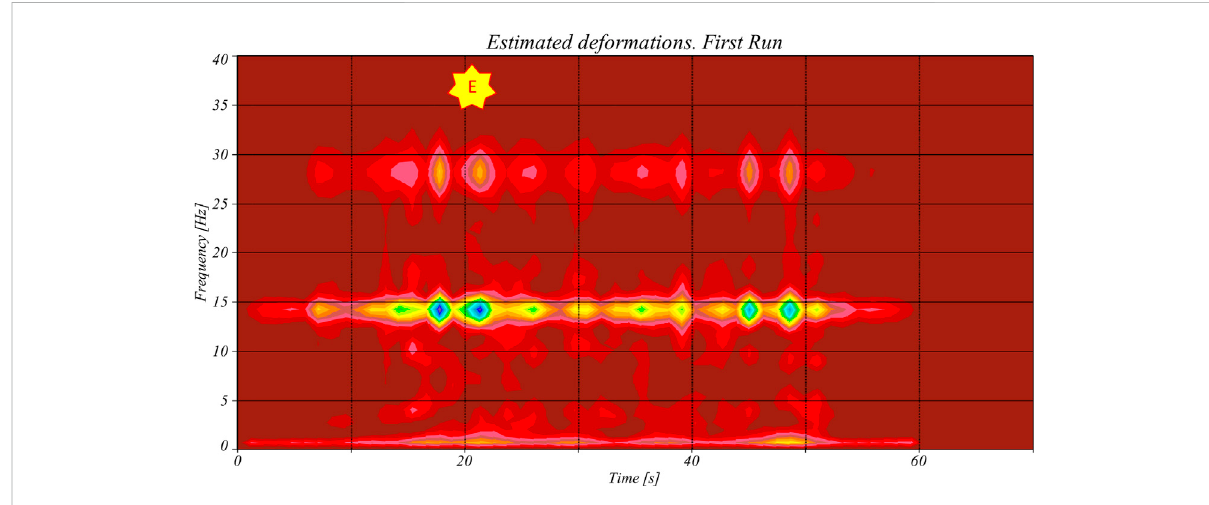
FIGURE 13 Spectrogram of the estimated deformations (First run).